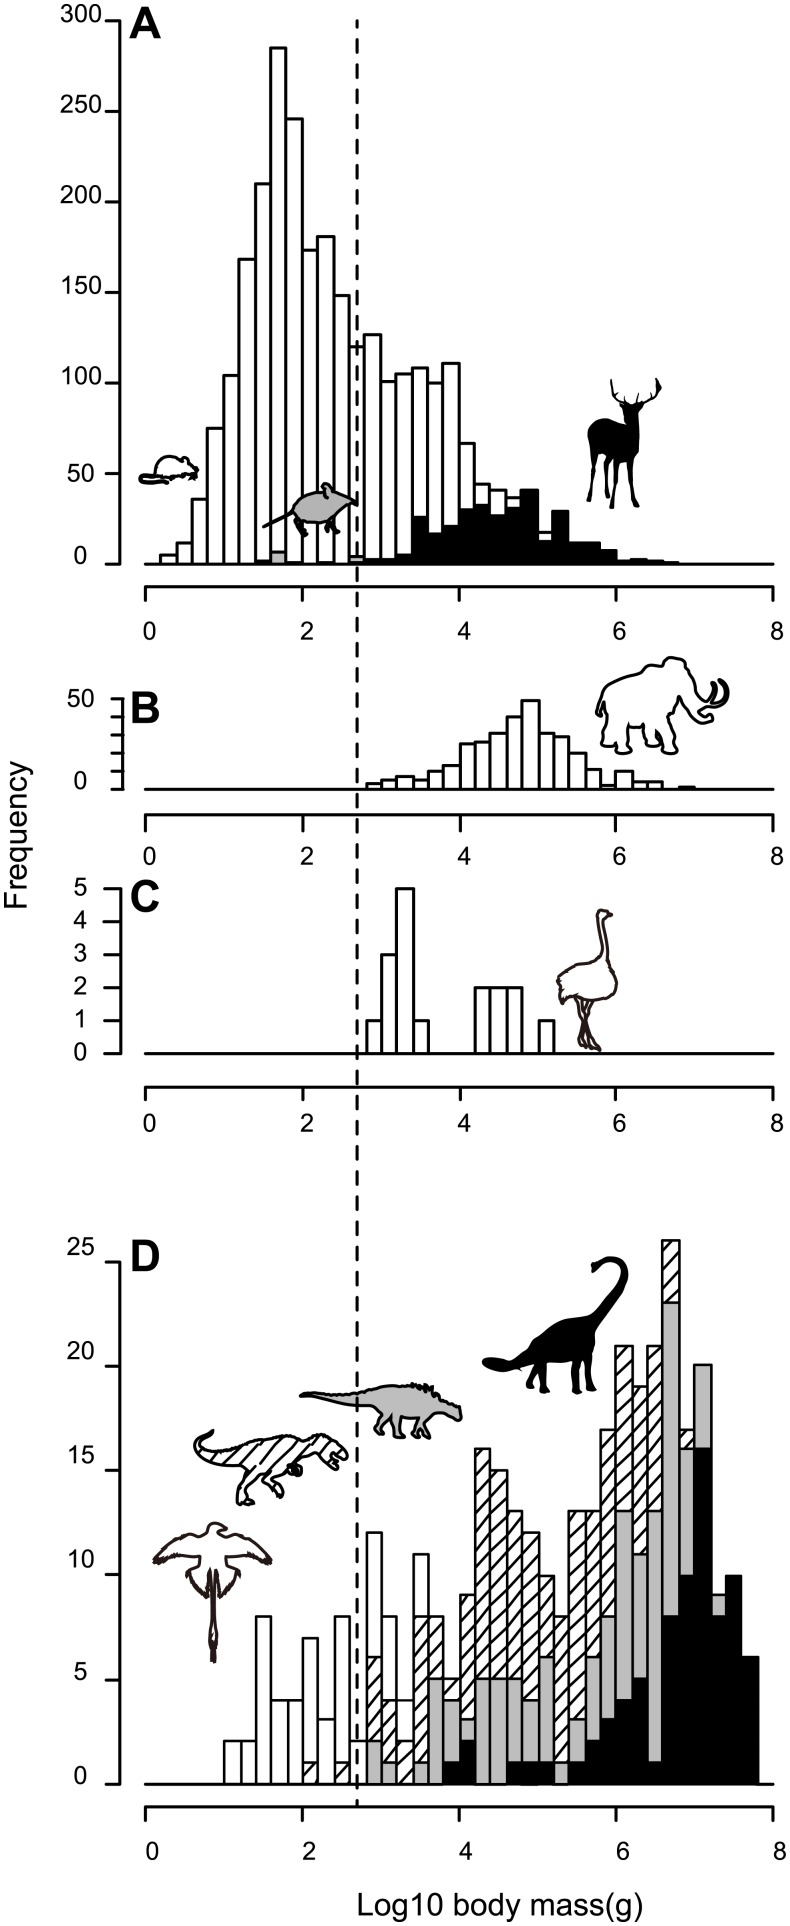
Body mass distribution for terrestrial tetrapod groups.Histograms for extant mammals of all foot postures (A), extinct Nearctic nonplantigrade mammals (B), nonvolant terrestrial birds (C), and Mesozoic dinosaurs including avialans (D). The dotted line indicates 500 g. In the histogram of extant mammals (A), plantigrade species are colored in white, species of Macroscelididae (elephant shrew) are in gray, and other nonplantigrade species are in black. In the histogram of dinosaurs (D), volant dinosaurs are in white, theropods are hatched, ornithischians are in gray, and sauropodomorphs are in black. Representatives of each group are shown as silhouettes on histograms. Except for Macroscelididae and two dinosaur species, all terrestrial nonplantigrade species were above 500 g. Except for nonvolant dinosaurs, the distributions of terrestrial nonplantigrade groups are not significantly different from a normal distribution.